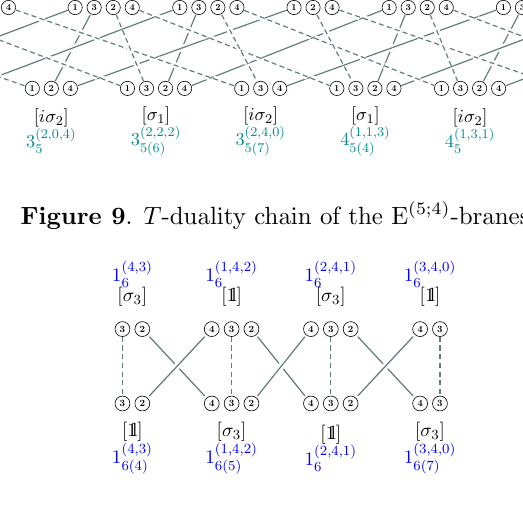
Figure 10 . T -duality chain of the E (6;4)